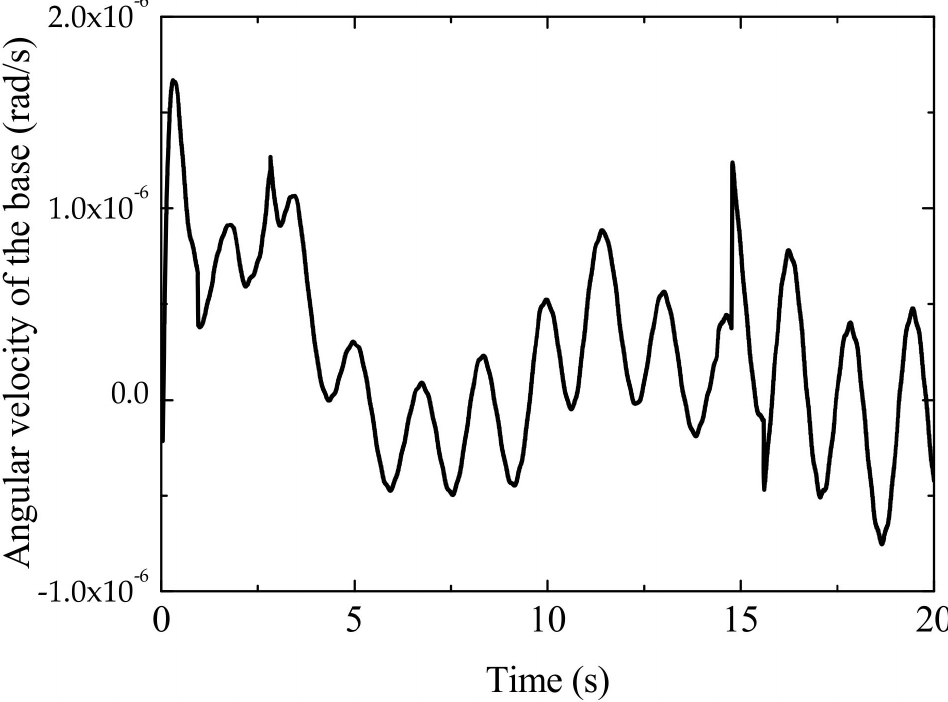
Figure 11. Angular velocity of the base in the preassembly